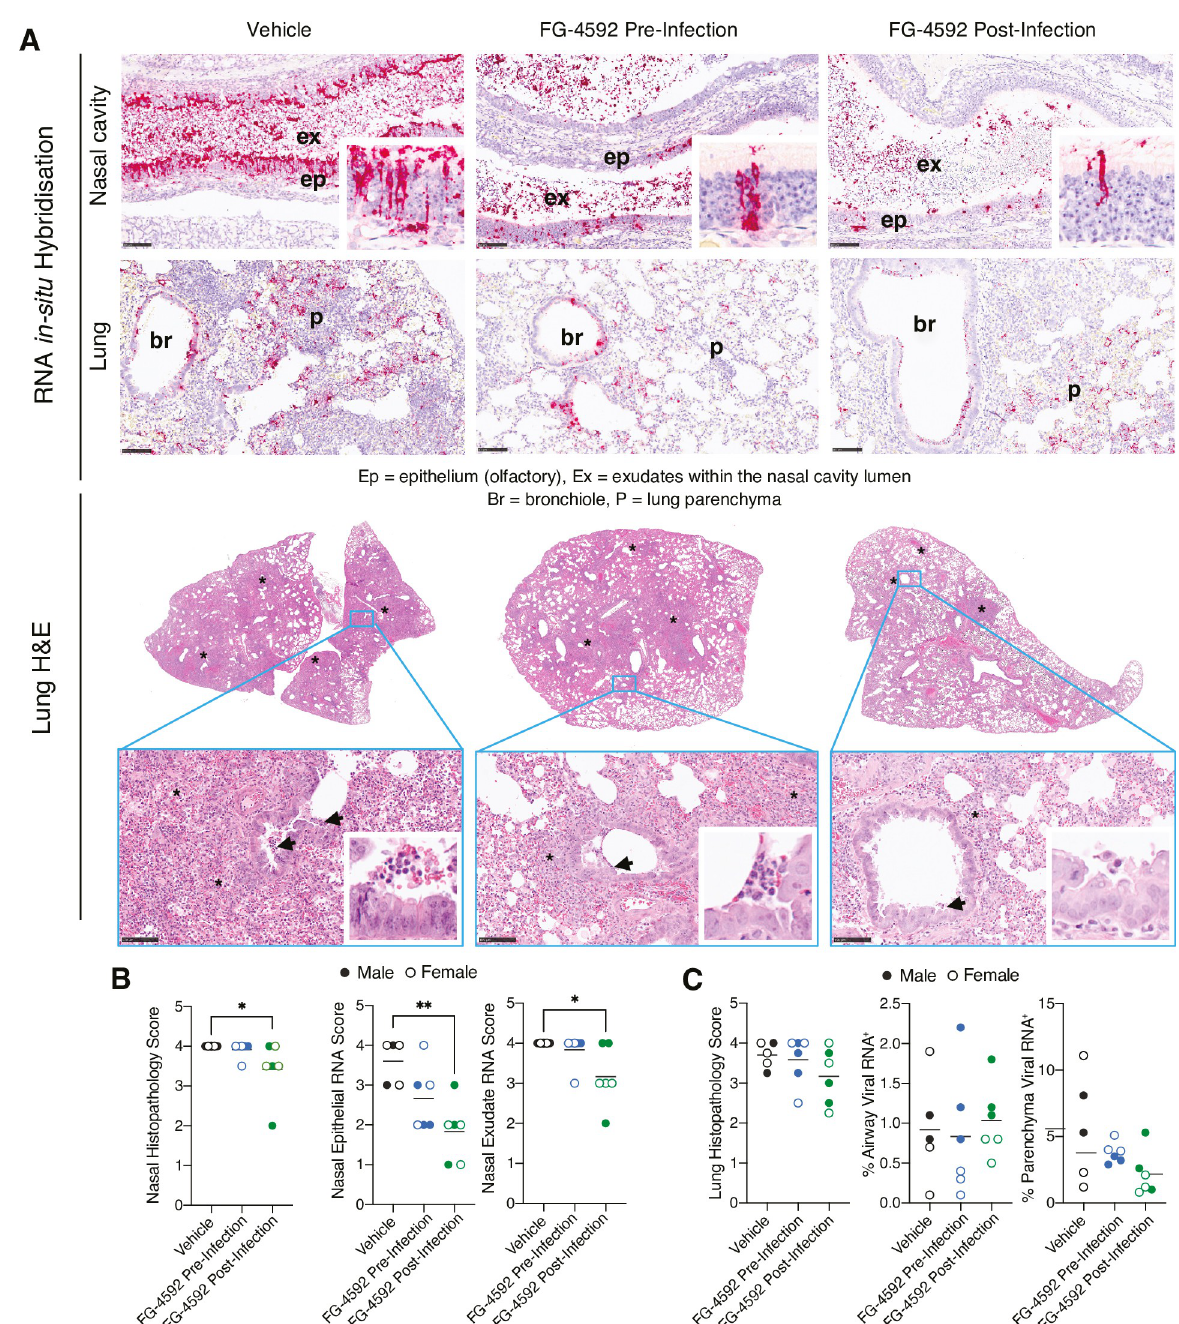
Fig 4. SARS-CoV-2 RNA and pathology in the nasal tract and lung. (A) Sections from the left lung and nasal cavity were stained with H&E to analyse histopathological changes and with RNA in-situ hybridisation (ISH) to detect SARS-CoV-2 RNA using probes specific for the viral Spike (S) transcript. Representative images from each treatment group are shown. Lung lesions consisted of multifocal broncho-interstitial pneumonia ( � ) with mild to moderate necrosis of the bronchiolar epithelium (arrows and H&E inserts) (see S5 Fig ). ISH shows abundant viral RNA in the nasal cavity epithelia that associates with mild to moderate necrosis (inserts) and within the airway epithelia and areas of inflammation. Scale bar = 100 μ m. (B) Nasal cavity was assessed for the presence and severity of lesions using a semi-quantitative scoring system from H&E-stained sections. SARS-CoV-2 RNA in the olfactory epithelium or exudates was quantified using the following scoring system: 0 = no positive staining; 1 = minimal; 2 = mild; 3 = moderate and 4 = abundant staining. (C) Lung pathology was assessed for the presence and severity of lesions using a semi-quantitative scoring system from H&E-stained sections. Digital image analysis calculated the area of lung airway and parenchyma staining for viral RNA. Statistical analysis was performed using a one-way ANOVA, p < 0.05 = � , p < 0.01 = �� . N = 5 animals for vehicle and N = 6 animals for each treatment